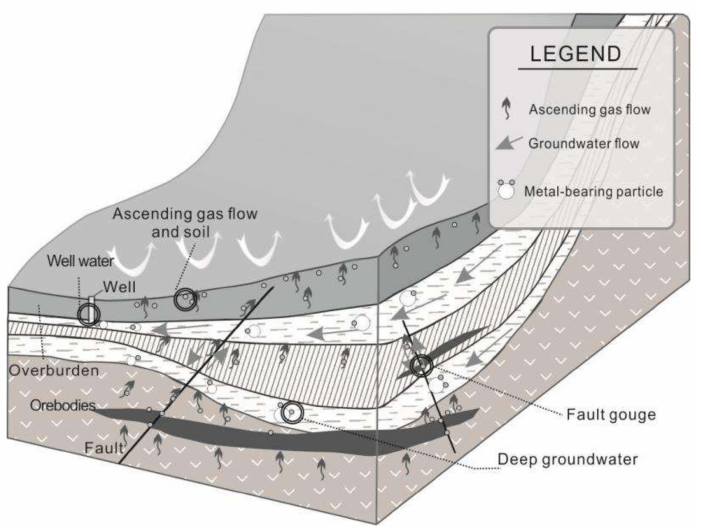
Figure 11. Schematic diagram: migration of ore-bearing particles in the Chaihulanzi deposit. Nanoparticles are generally charged, with a high surface-to-volume ratio [84]. Thus, they have excellent absorptivity [40,58]. Recent research showed that the ore-bearing nanoparticles are absorbed and migrated by other nanoparticles [31,33,35,85]. The sorption of gold nanoparticles by sulfide via electrostatic interaction was confirmed by a synthesis experiment [86]. In this study, many natural ore-bearing nanoparticles were absorbed by other natural nanoparticles in deep-seated fault gouge (Figure 5e,f; ID6 and 7), ascending gas flow (Figure 6f; ID13), soil (Figure 8b; ID15), and groundwater samples (Figure 8a; ID20) indicating that the phenomenon of natural ore-bearing nanoparticles being absorbed and aided in migration by other natural nanoparticles is universal. In short, the natural ore-bearing nanoparticles are produced from concealed orebodies during faulting and oxidation, and are carried and transported by groundwater and ascending gas flows to the surface, during which some nanoparticles are absorbed by other